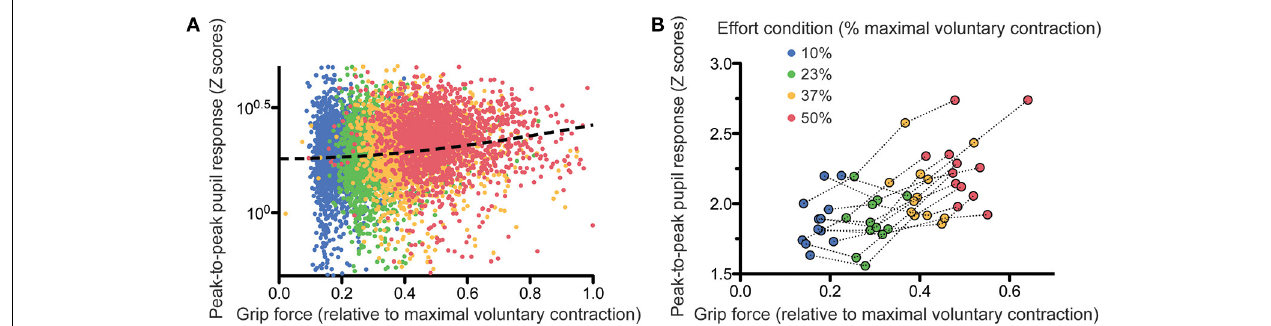
FIGURE 4 | Relation between grip force and pupil size response, trial-by-trial (A) and subject-by-subject (B). The dashed line on (A) shows the quadratic fit on the